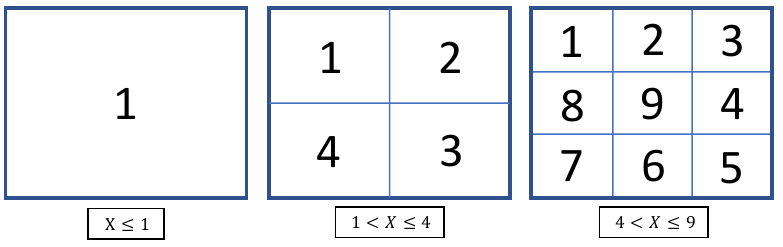
Figure 12. Order in which images were acquired.